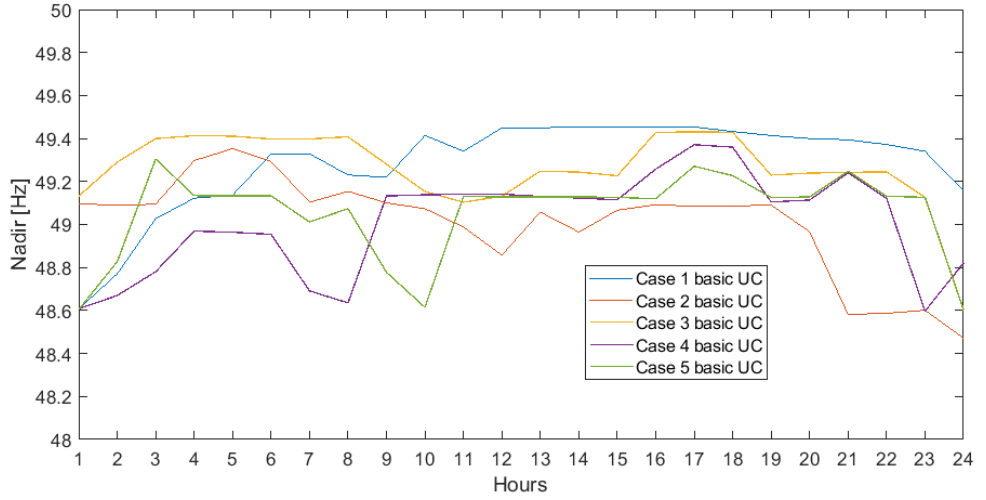
Figure 6. 24-h nadir for five cases of basic